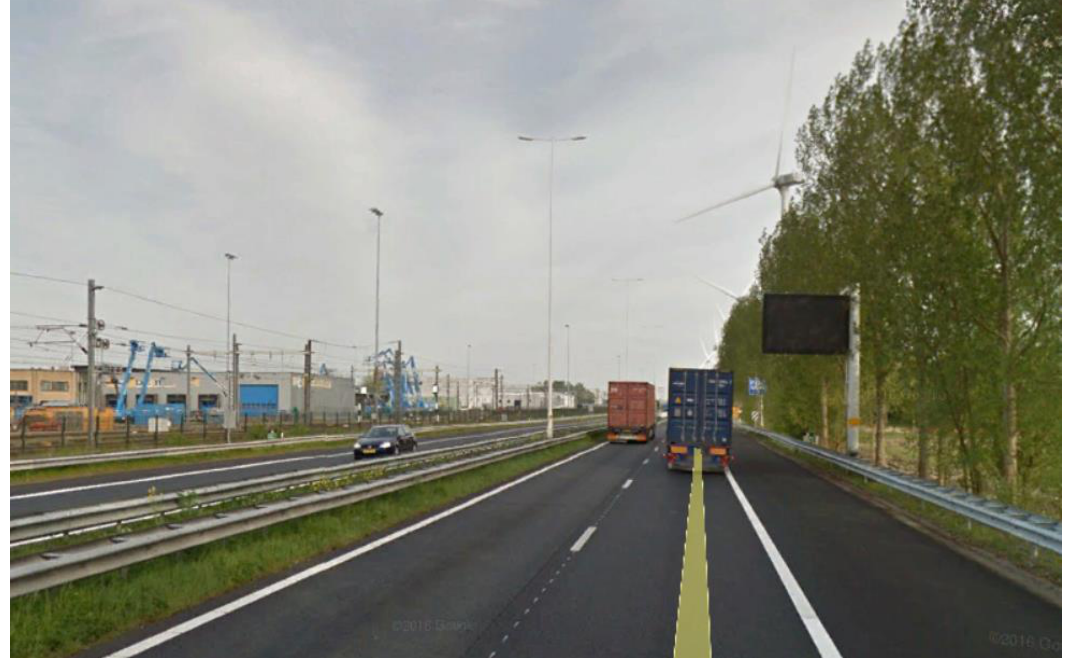
Figure 2. Research location. Street view near camera 1 after construction of wind turbines (image adopted from Google Street